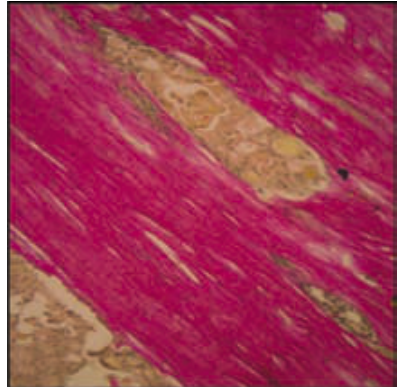
Fig. 7. Linearised collagen Picrosirius red x 100